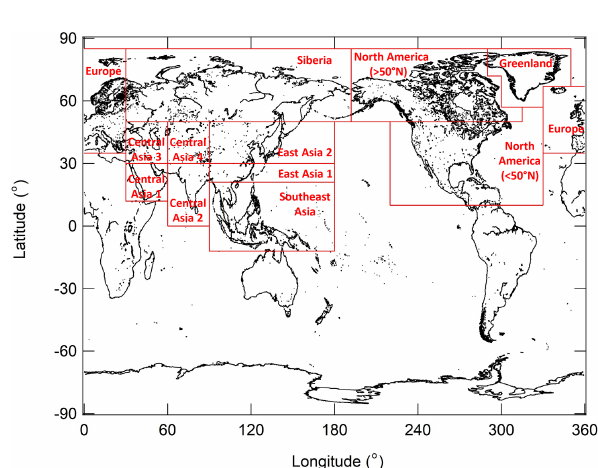
Figure 1. The definition of source regions used in this study. The 13 source regions are Europe (EUR), Siberia (SIB), Greenland (GL), North America north of 50 ◦ N (NAM ( > 50 ◦ N)), North America south of 50 ◦ N (NAM ( < 50 ◦ N)), Central Asia (CAS) 1–4, East Asia (EAS) 1–2, Southeast Asia (SAS), and others. Anthropogenic and biomass burning BC from each source region is tracked by tag tracers in global aerosol model simulations using CAM-ATRAS (Sect.